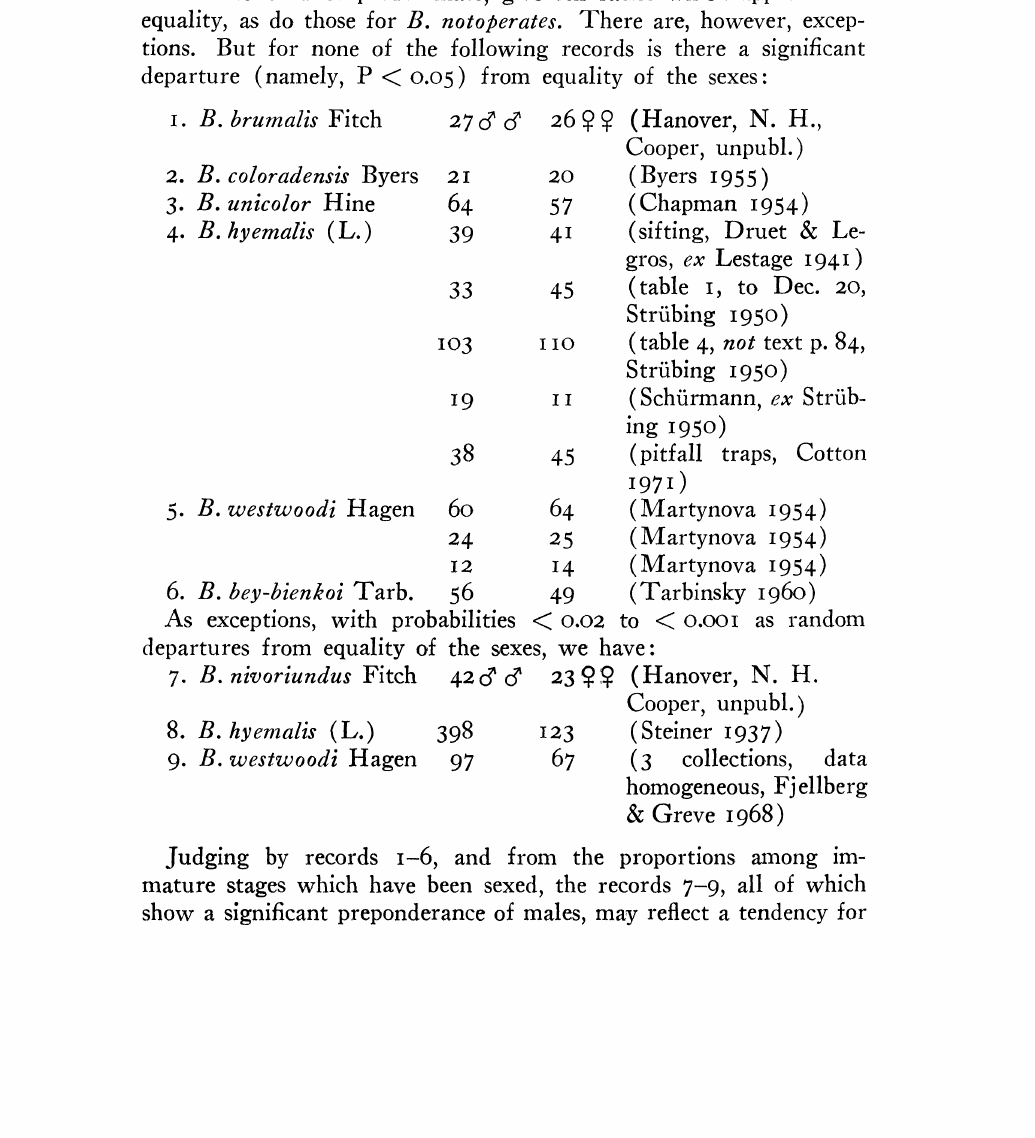
(table I, to Dec. 2o, (table 4, not text p.